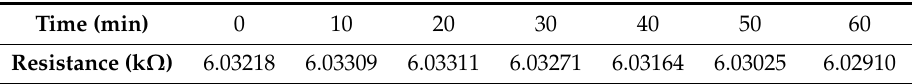
Table 5. The data of the short-term stability